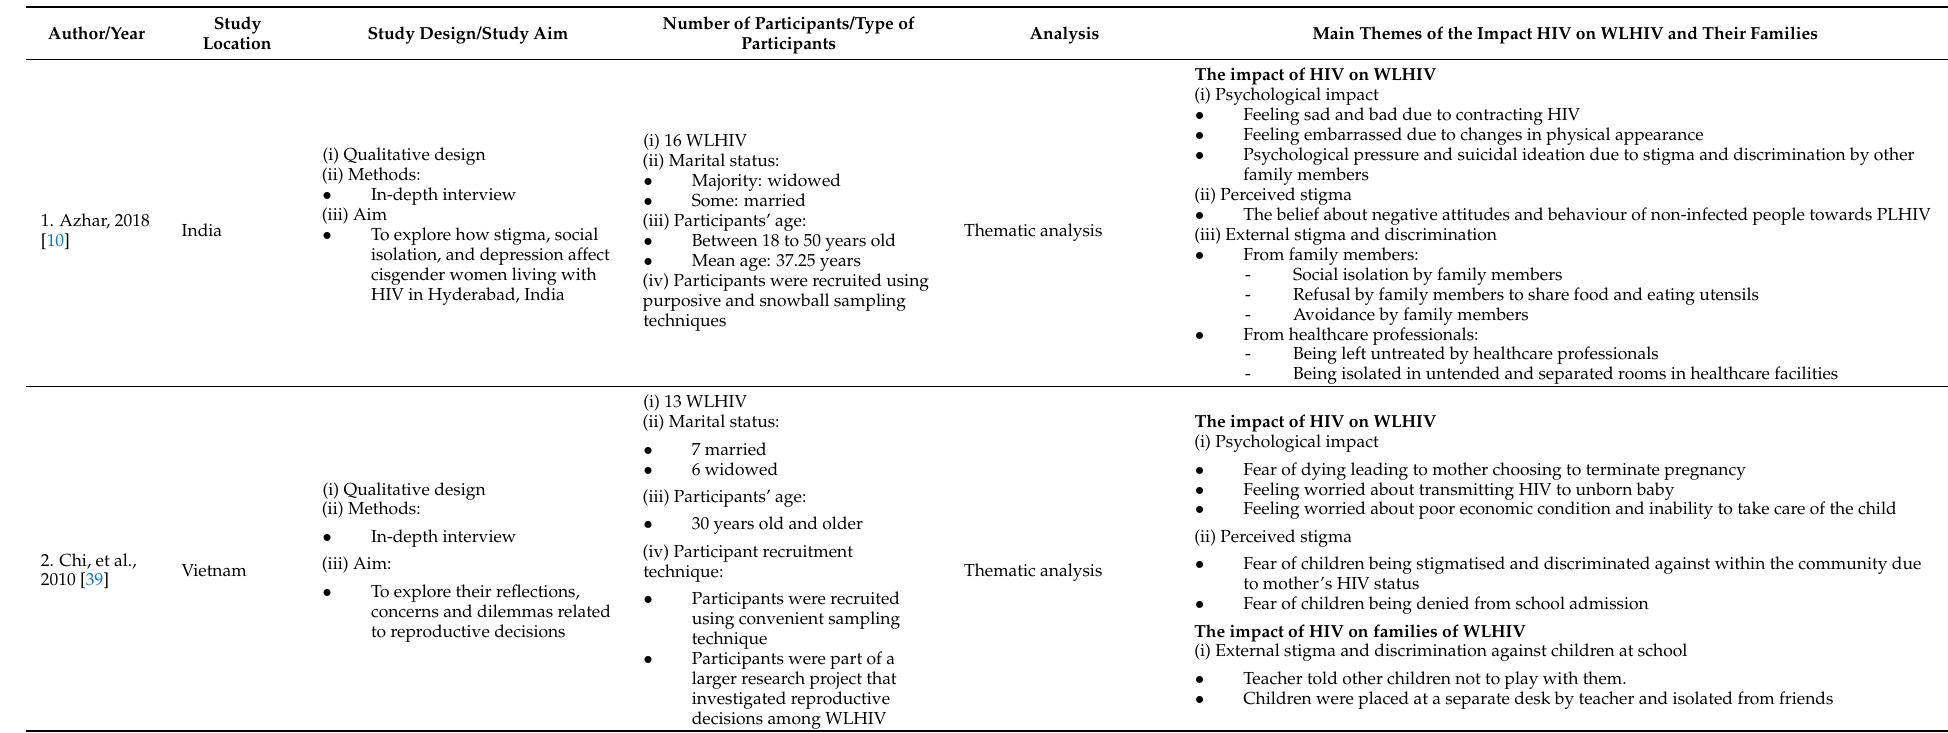
Table 1. A description of the included studies in alphabetical